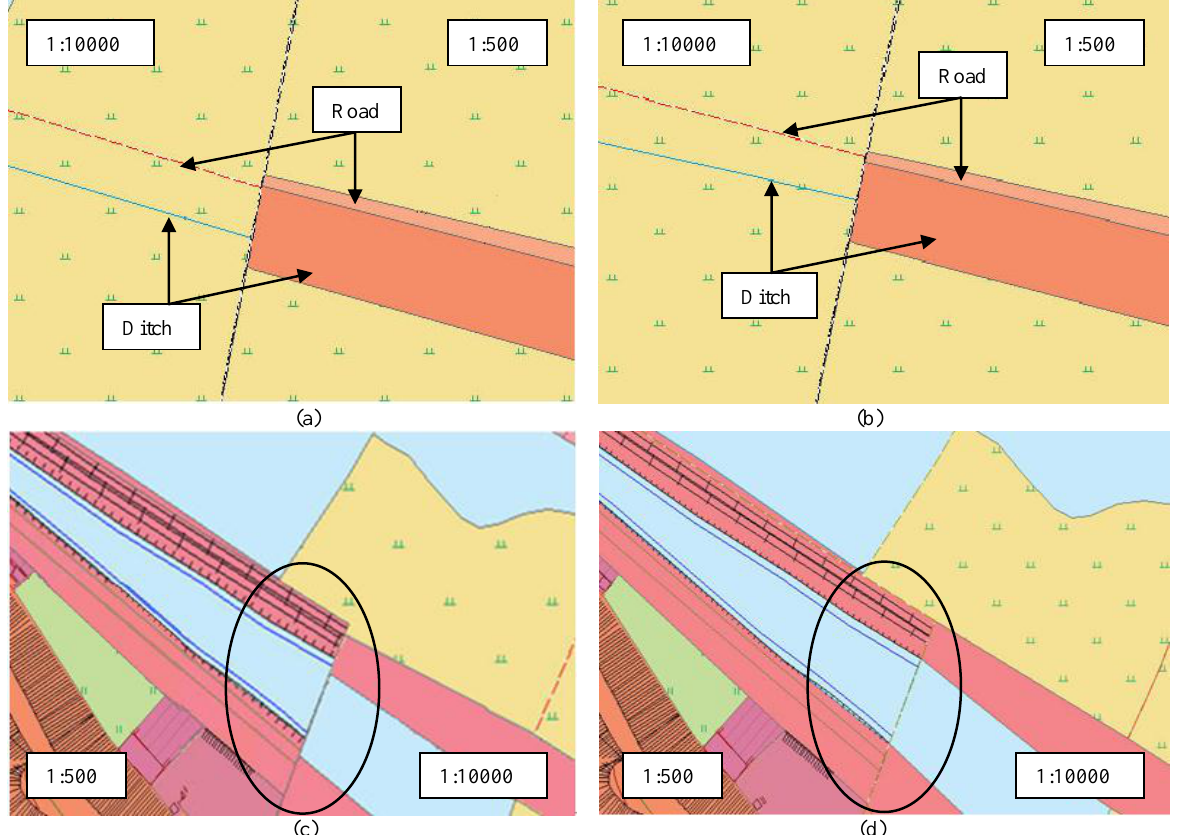
Figure 10. Data integration of urban and rural in different scale and coordinates